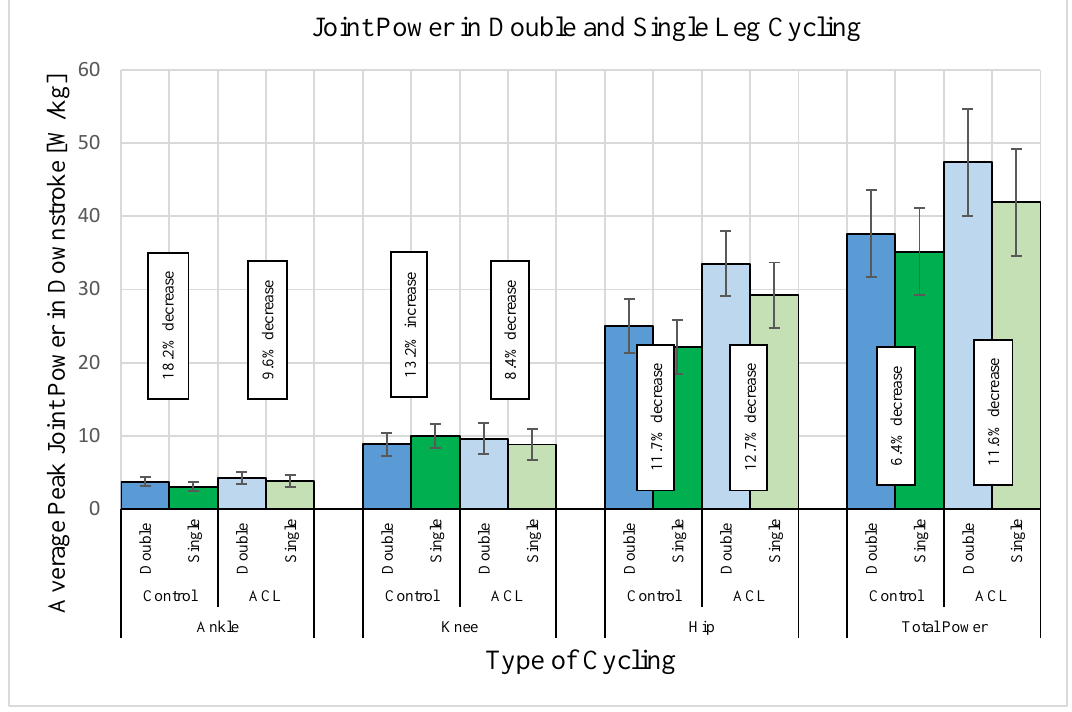
Figure 4. Average maximum joint power in the downstroke (no significance was found; p < 0.05).